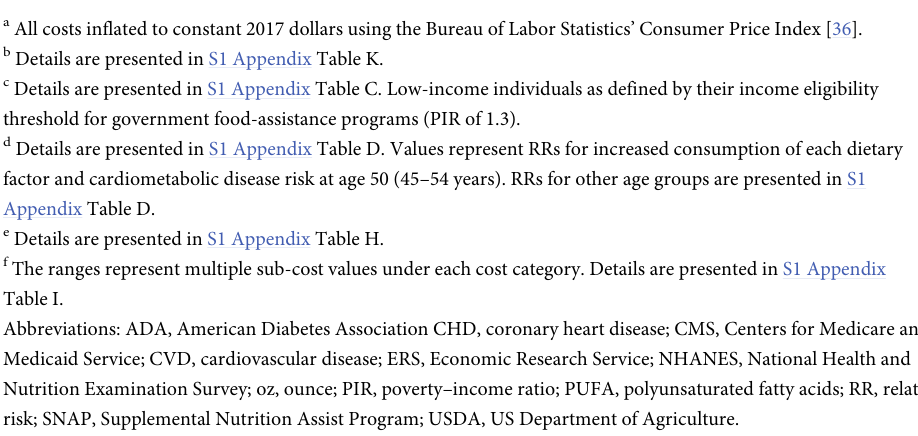
Abbreviations: ADA, American Diabetes Association CHD, coronary heart disease; CMS, Centers for Medicare and Medicaid Service; CVD, cardiovascular disease; ERS, Economic Research Service; NHANES, National Health and Nutrition Examination Survey; oz, ounce; PIR, poverty–income ratio; PUFA, polyunsaturated fatty acids; RR, relative risk; SNAP, Supplemental Nutrition Assist Program; USDA, US Department of